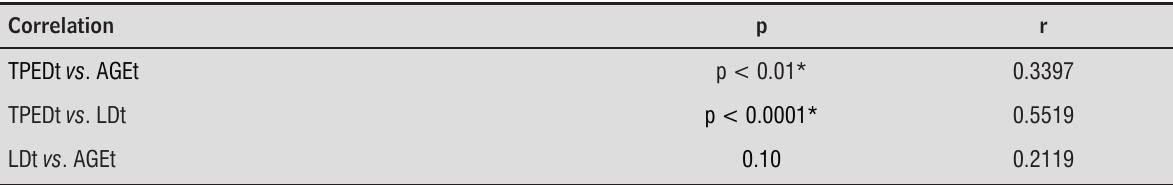
Table 3 - Correlations between LD, TPED, and age